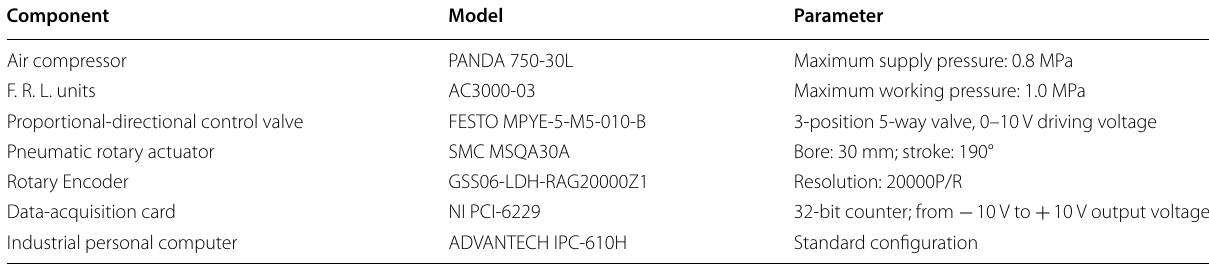
Table 1 Models and parameters of the